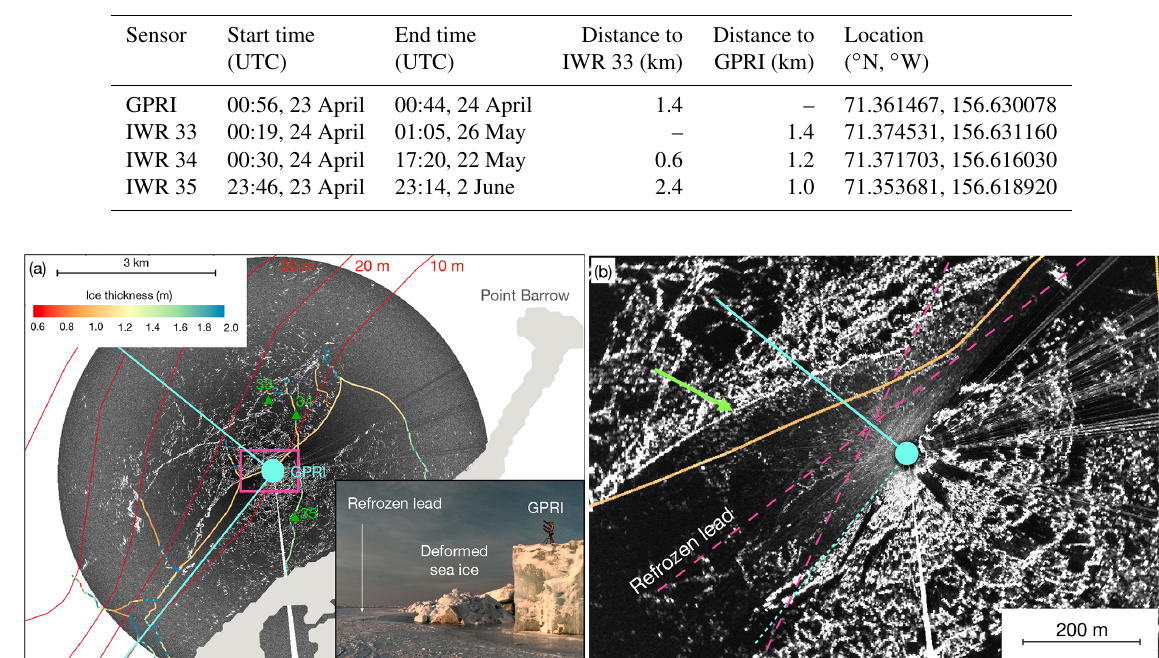
Figure 1. (a) Location of the GPRI superimposed on scan-mode backscatter imagery. The GPRI stared in the direction of the cyan lines. Bathymetry contours are drawn in red. Location of IWRs is identified with green triangles. Multi-colored line shows ice thickness as indicated by the color bar. Land is masked out in light gray. The pink rectangle indicates the location of the zoomed-in area in panel (b) . (b) Zoomed-in area of the refrozen lead adjacent to the GPRI. The dashed pink lines indicate possible directions of wave propagation commented on in the text. The green arrow in panel (b) indicates the deformed offshore edge of the refrozen lead.